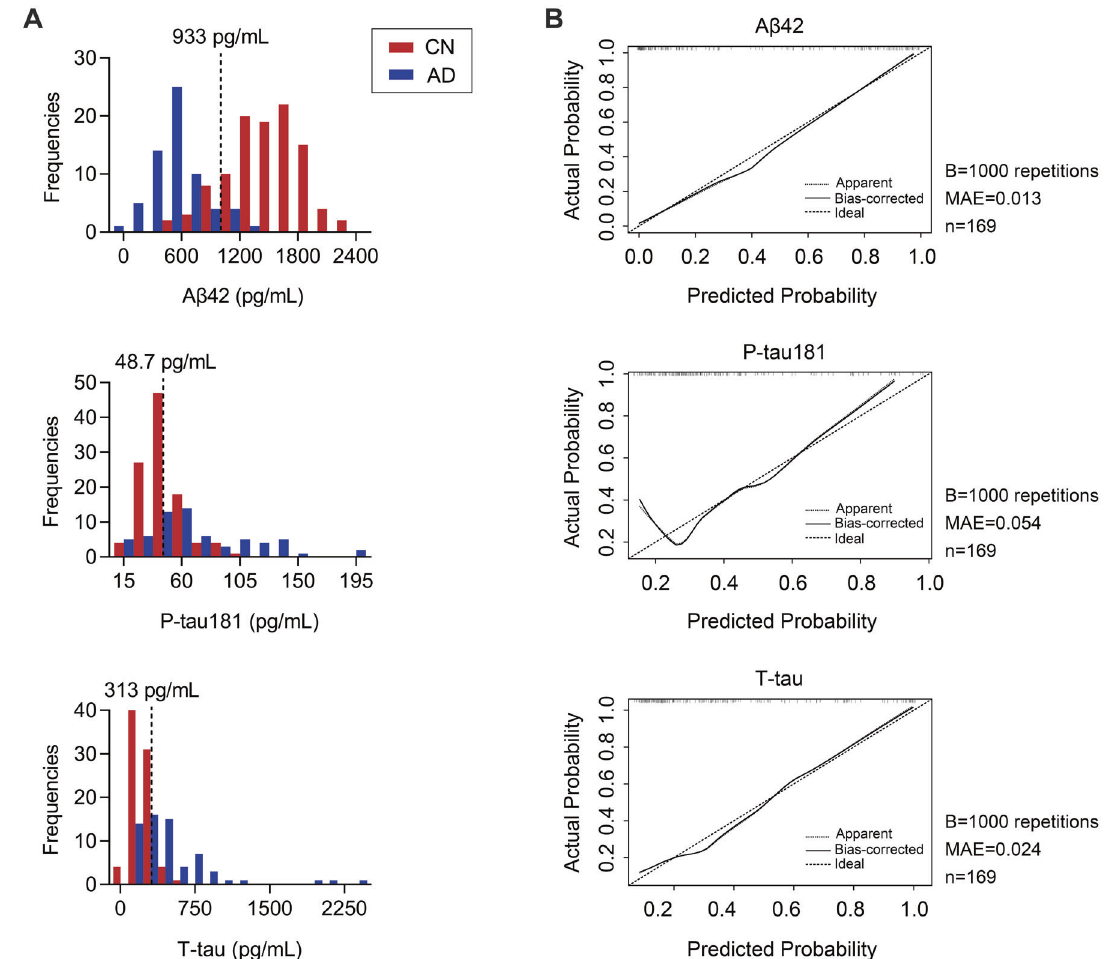
Fig. 2 Frequency distribution and internal validation of single CSF biomarkers. A Frequency distribution of CSF A β 42, P-tau181, and T-tau. The dashed vertical lines indicate the cutoff value for each biomarker. B The bootstrap-validated of CSF A β 42, P-tau181, and T-tau. The Y-axis indicates the actual probability of AD and the X-axis indicates the predicted probability of AD. The 45-degree black dotted line represents the ideal prediction; the solid black line surrounding the 45-degree black dotted line represents the bias-corrected prediction; the black dotted line surrounding the 45-degree black dotted line represents the apparent prediction. AD, Alzheimer ’ s disease; CN, cognitively normal; MAE, mean absolute among our apparent model, the Bias-corrected model, and the ideal model (A β 42: MAE = 0.013; T-tau: MAE = 0.024), while P-tau181 had a medium fi t (MAE = 0.054) (Fig. 2B), indicating